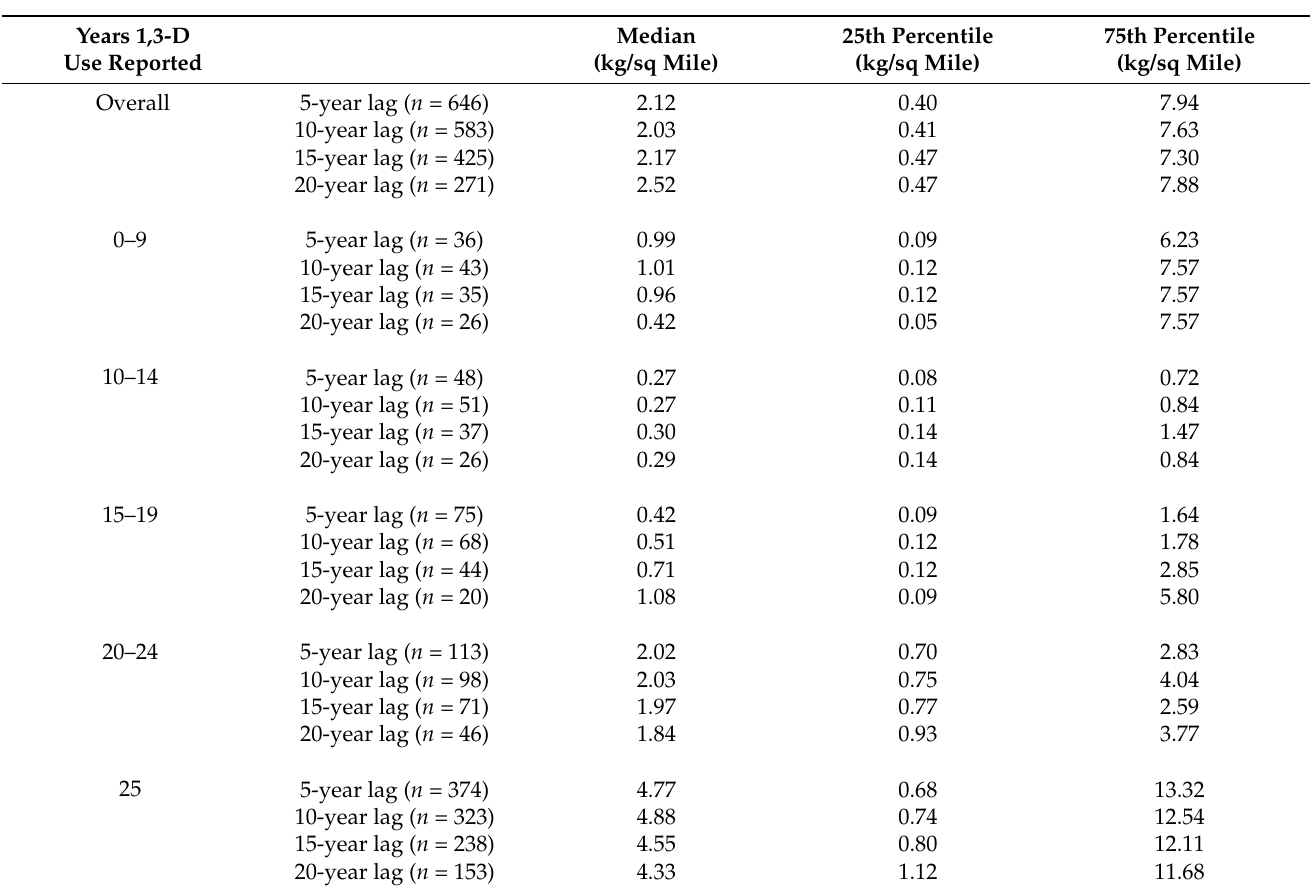
Table 1. Median and interquartile range of 1,3 dichloropropene use by number of years of use data reported to the USGS, 1992–2016.